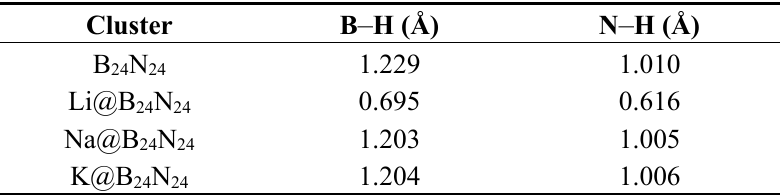
Table 6. Bond length of B–H and N–H on M@B 24 N 24 .